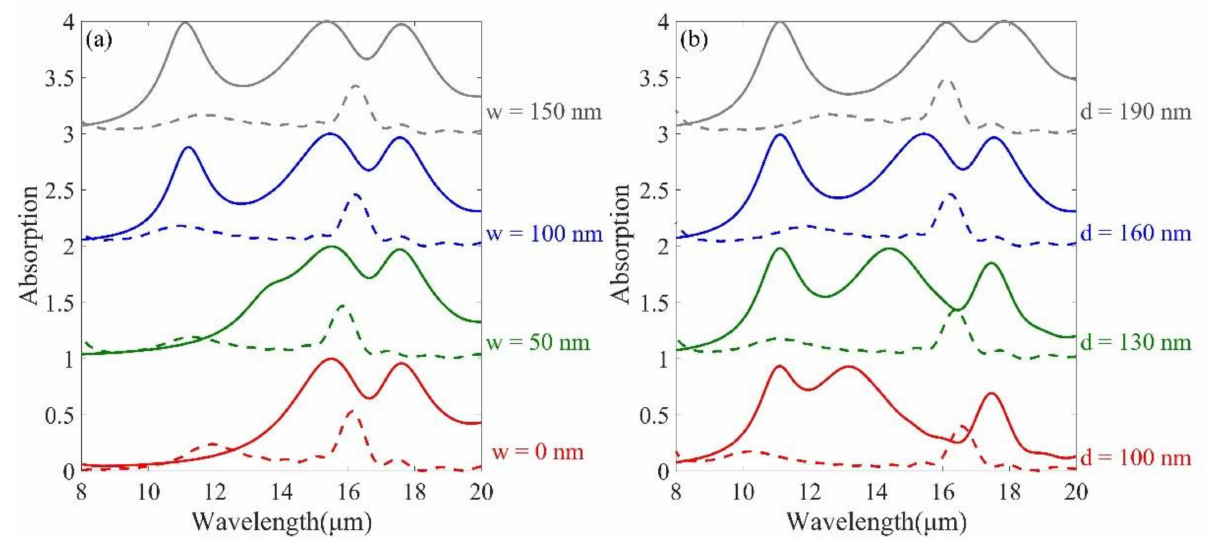
Figure 4. ( a ) Absorption spectra of the middle GST layer of nanodisks with crystalline and amorphous phases at different heights. ( b ) Absorption patterns of bottom GST films with crystalline and amorphous phases at different heights. The other geometric parameters are the same as in Figure